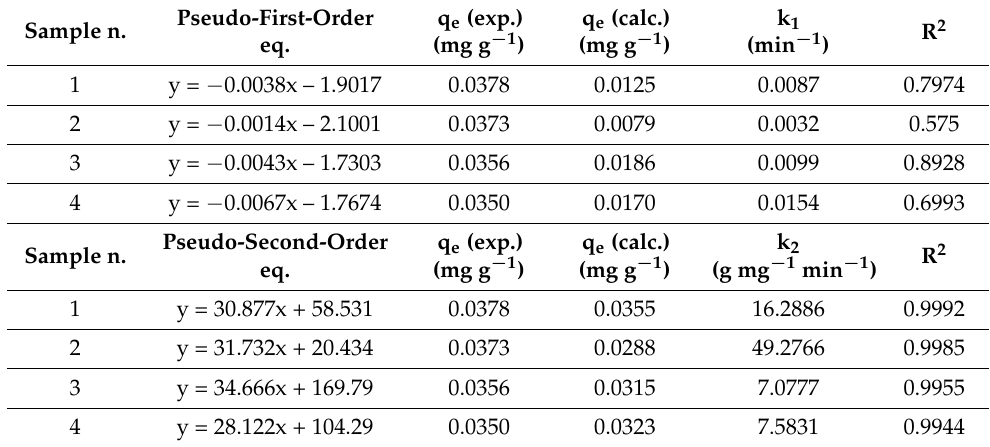
Table 2. Adsorption kinetic model rate constants for MO on investigated samples. Sample n.